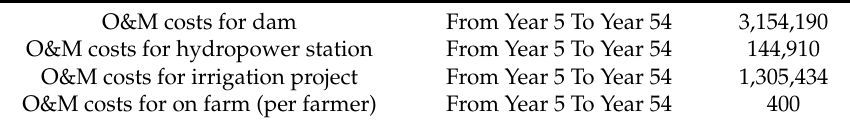
Table A8. Operating, maintenance and management (O&M) costs